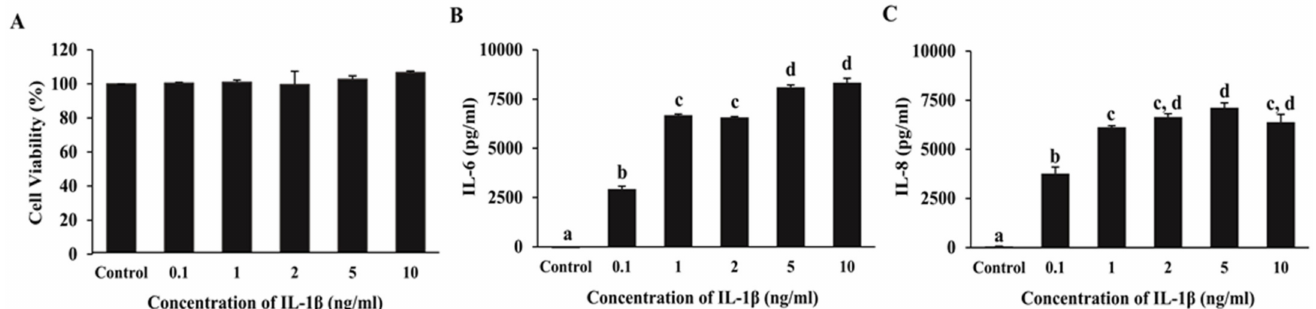
Figure 3. Effect of IL-1 β on IL-6 and IL-8 secretion and viability of ARPE-19 cells. The viability of cells was evaluated using an MTT assay ( A ). IL-6 ( B ) and IL-8 ( C ) in the supernatants of IL-1 β treated cells were measured using ELISA. Data are presented as mean ± SD ( n = 3). The different superscripts (a–d) indicate significant differences among groups at p <